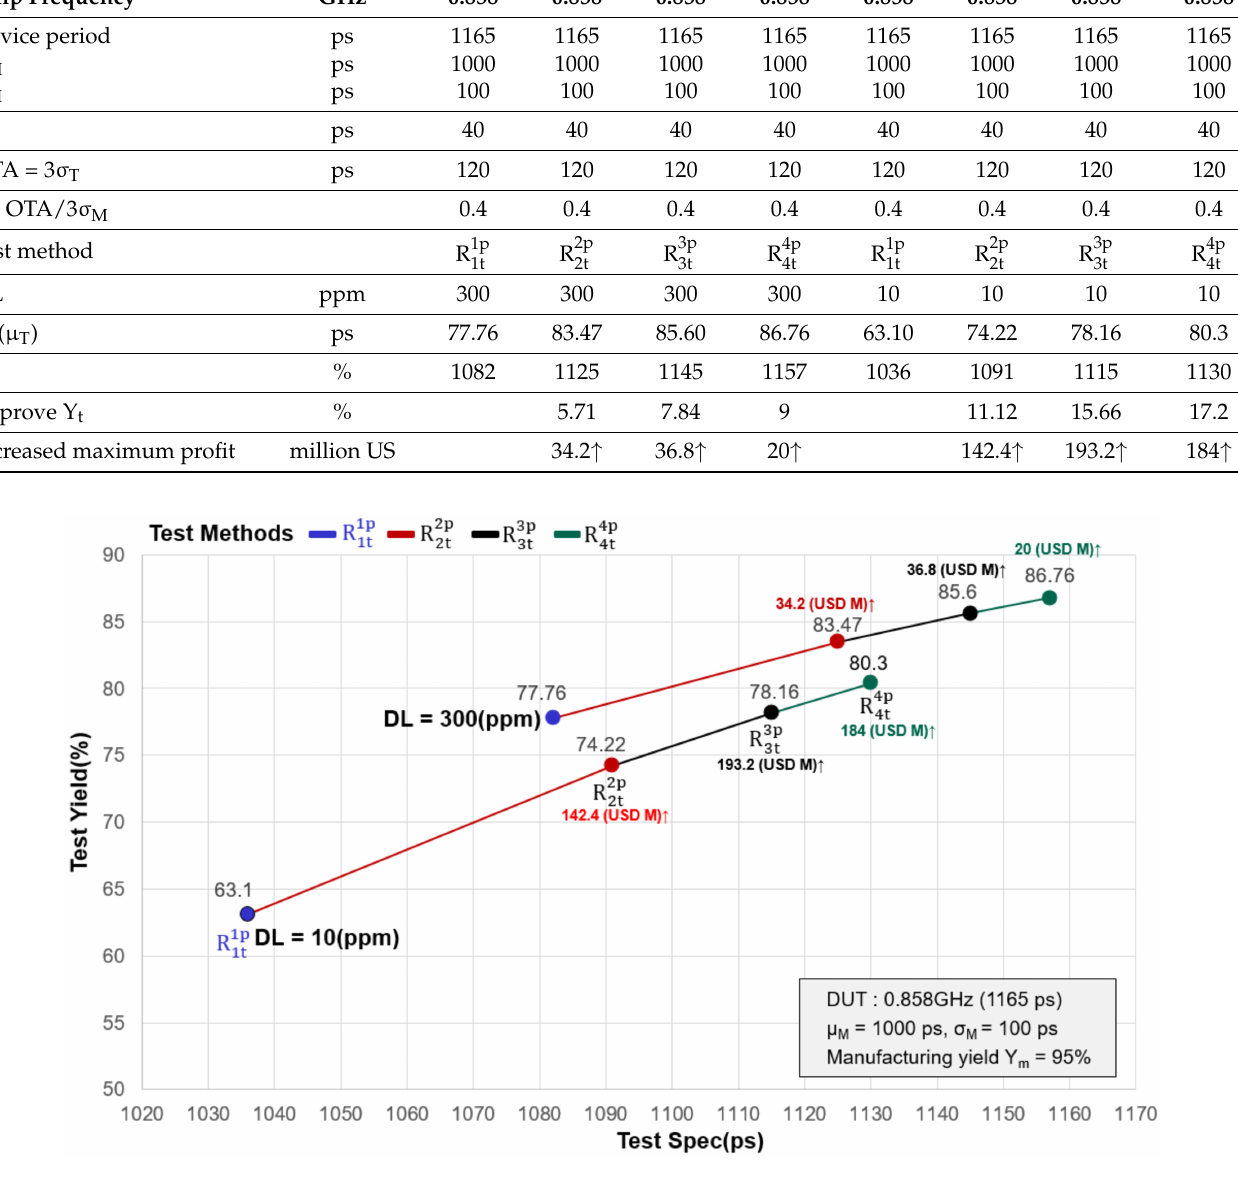
Figure 10. Comparison of the improved test yield of repeated tests (TRTS) under different quality